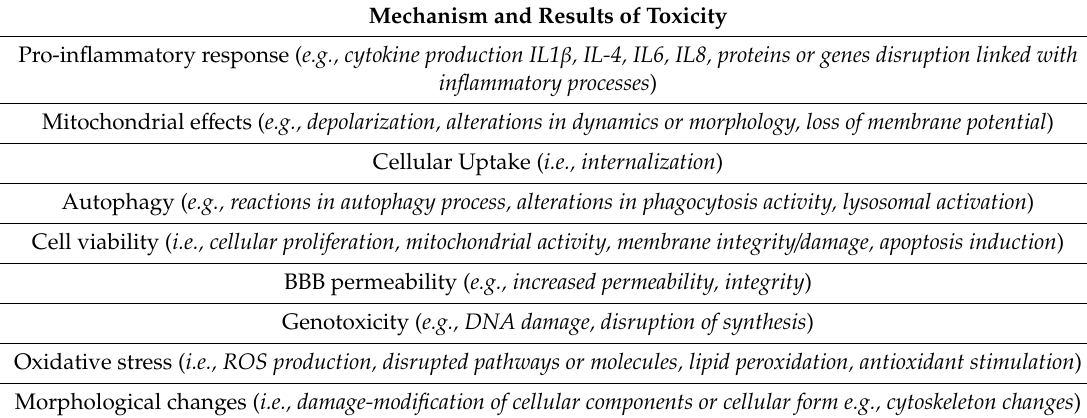
Table 1. Results of toxicological endpoints from in vitro neuronal assays, extracted as outcomes for use in developing the model (list of biological endpoints not